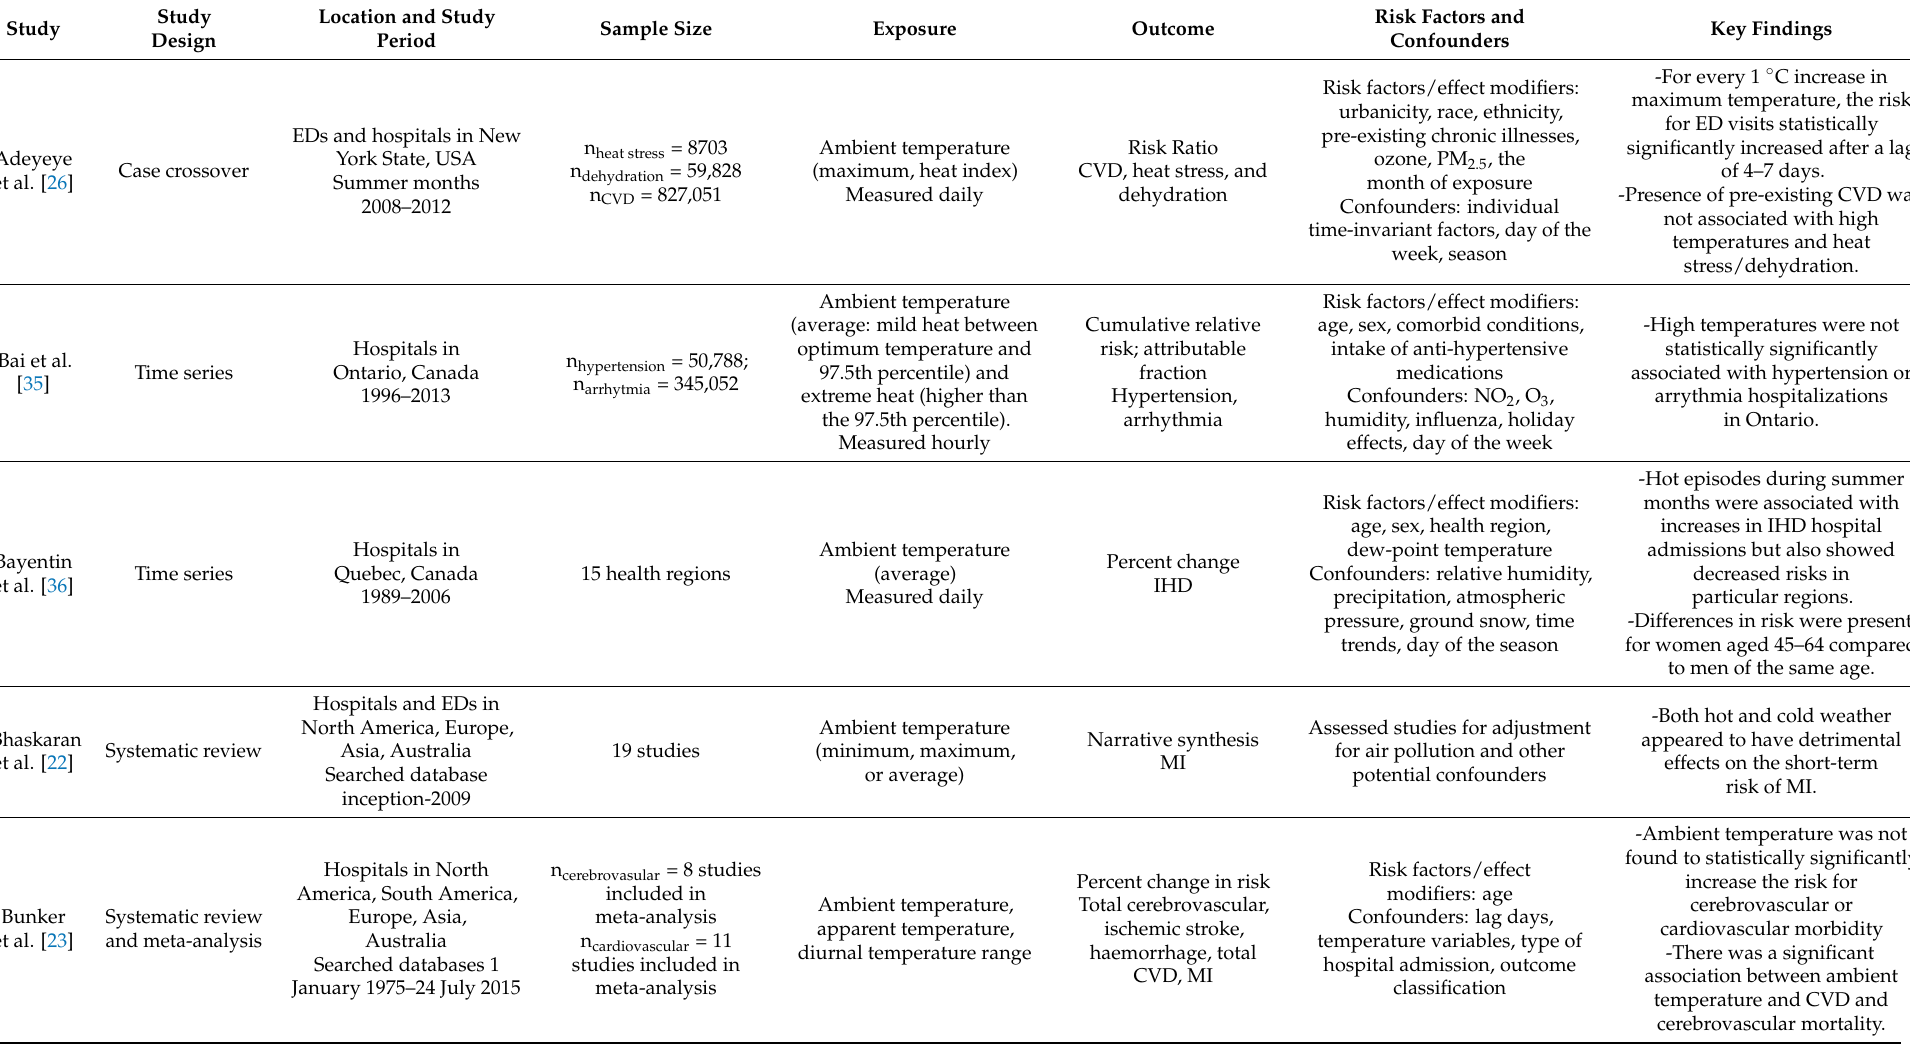
Table 1. Data extraction from included